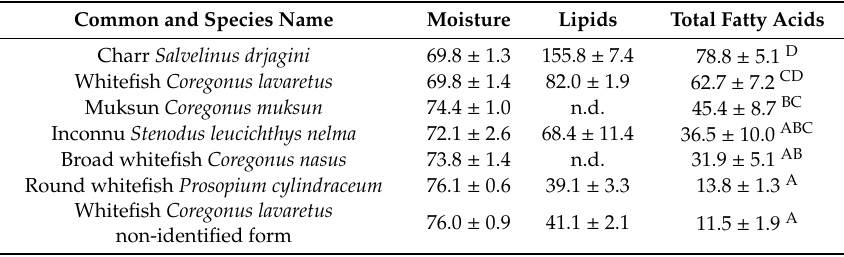
Table 2. Average ( ± SE—standard errors) moisture content (% wet weight), lipid content (mg g − 1 wet weight) and sum fatty acid content for total lipids (mg g − 1 wet weight) in muscle tissues of fish species caught in Siberian arctic lakes, 2017. Means of total fatty acids labeled with the same letter are not significantly di ff erent at P < 0.05 after ANOVA post hoc Tukey HSD